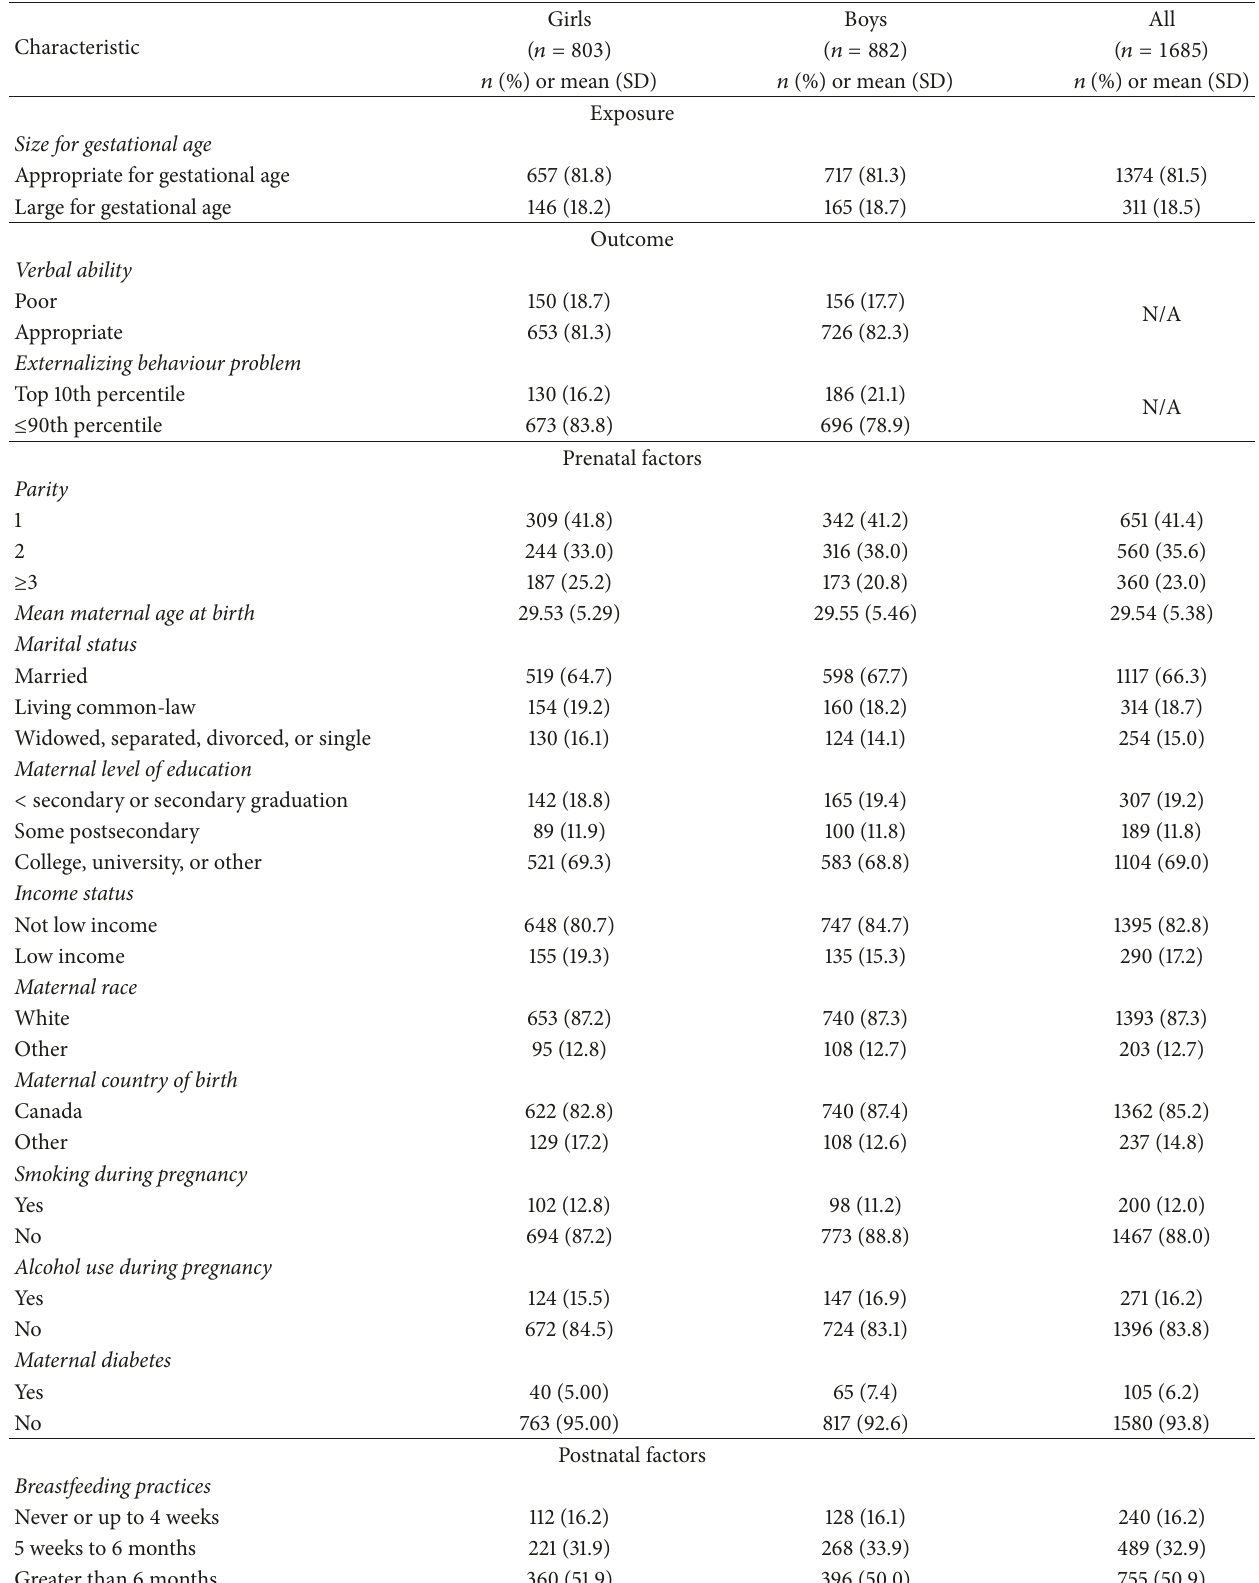
Table 1: Baseline characteristics of boys and girls aged 0–3